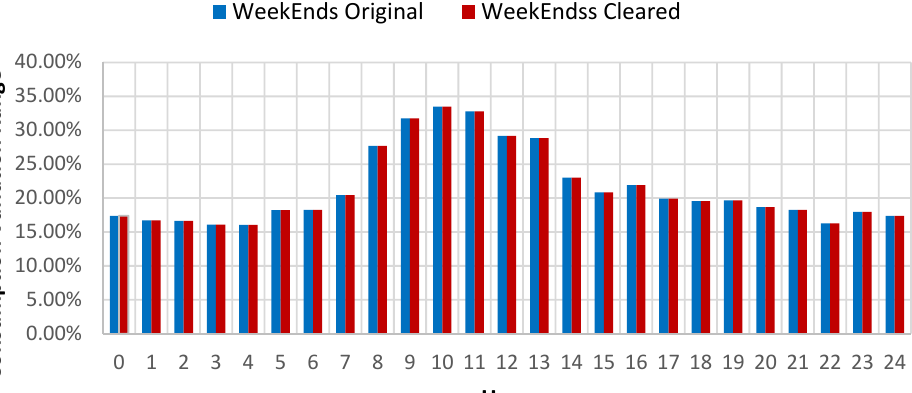
Figure 13. Energy consumption variation range compared to hourly average weekends consumption for original and cleared data sets.